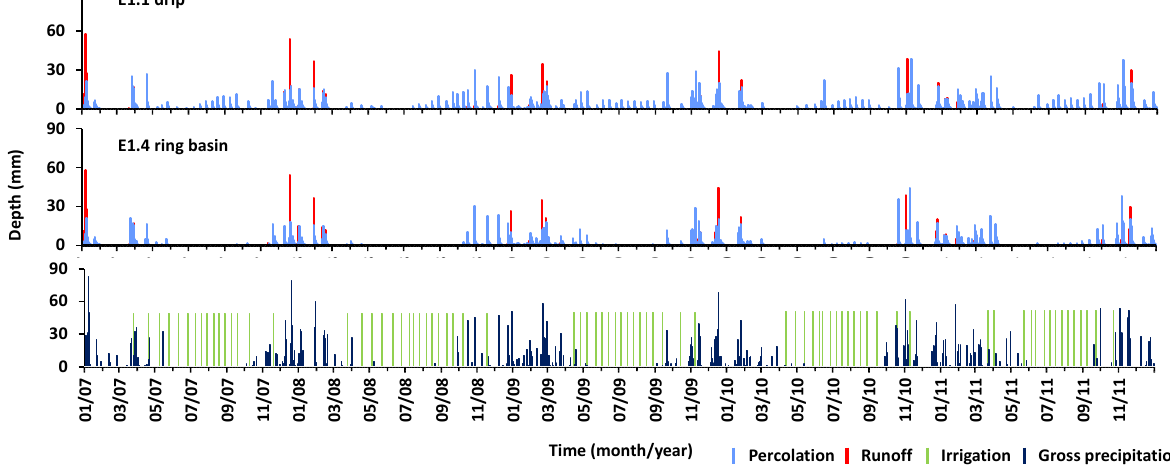
Figure 7. Daily values of percolation and runoff in E1.1 drip and E1.4 ring-basin plots during the 2007–2011 growing seasons (E1). Table 12. Components of the annual water balance relative to the E2 growing seasons.